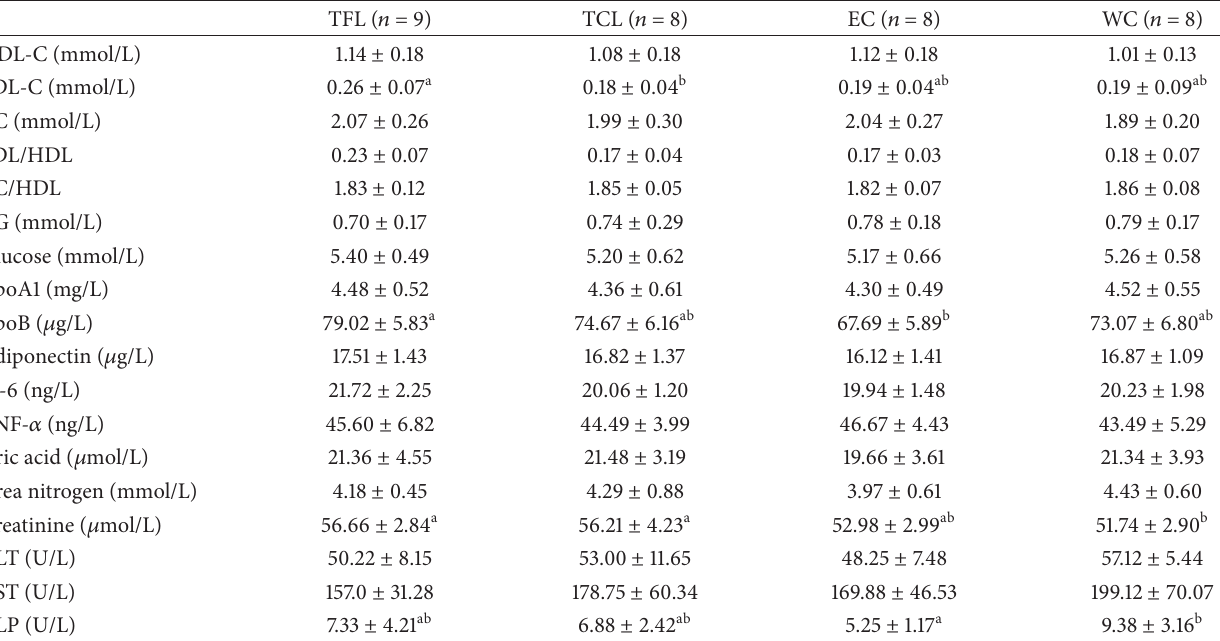
Table 3: Plasma lipids and other parameters after consumption of TFL and